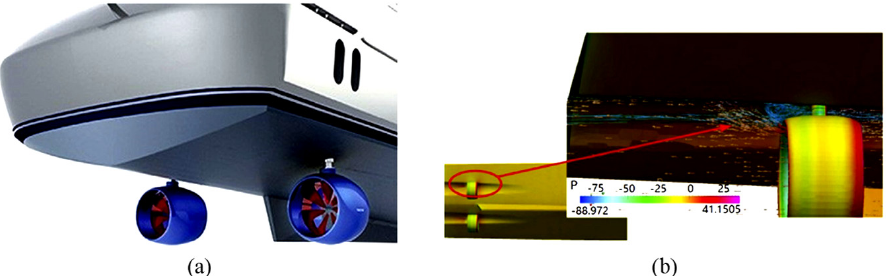
Figure 8. Interaction between duct and hull of a yacht: ( a ) yacht equipped with two RDTs; ( b ) water flow pattern behind the RDT [39].